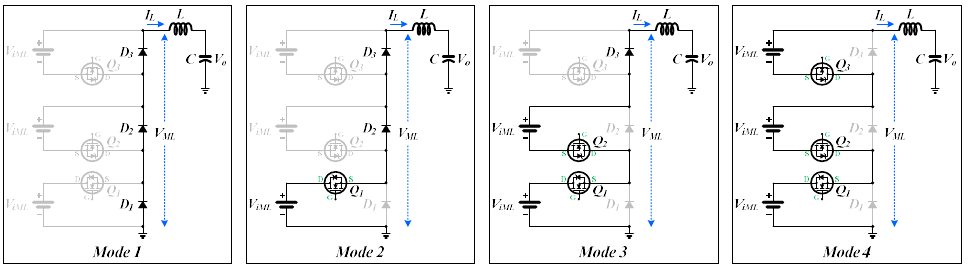
Figure 4. Operational state of DSS-MLC according to the switching state.